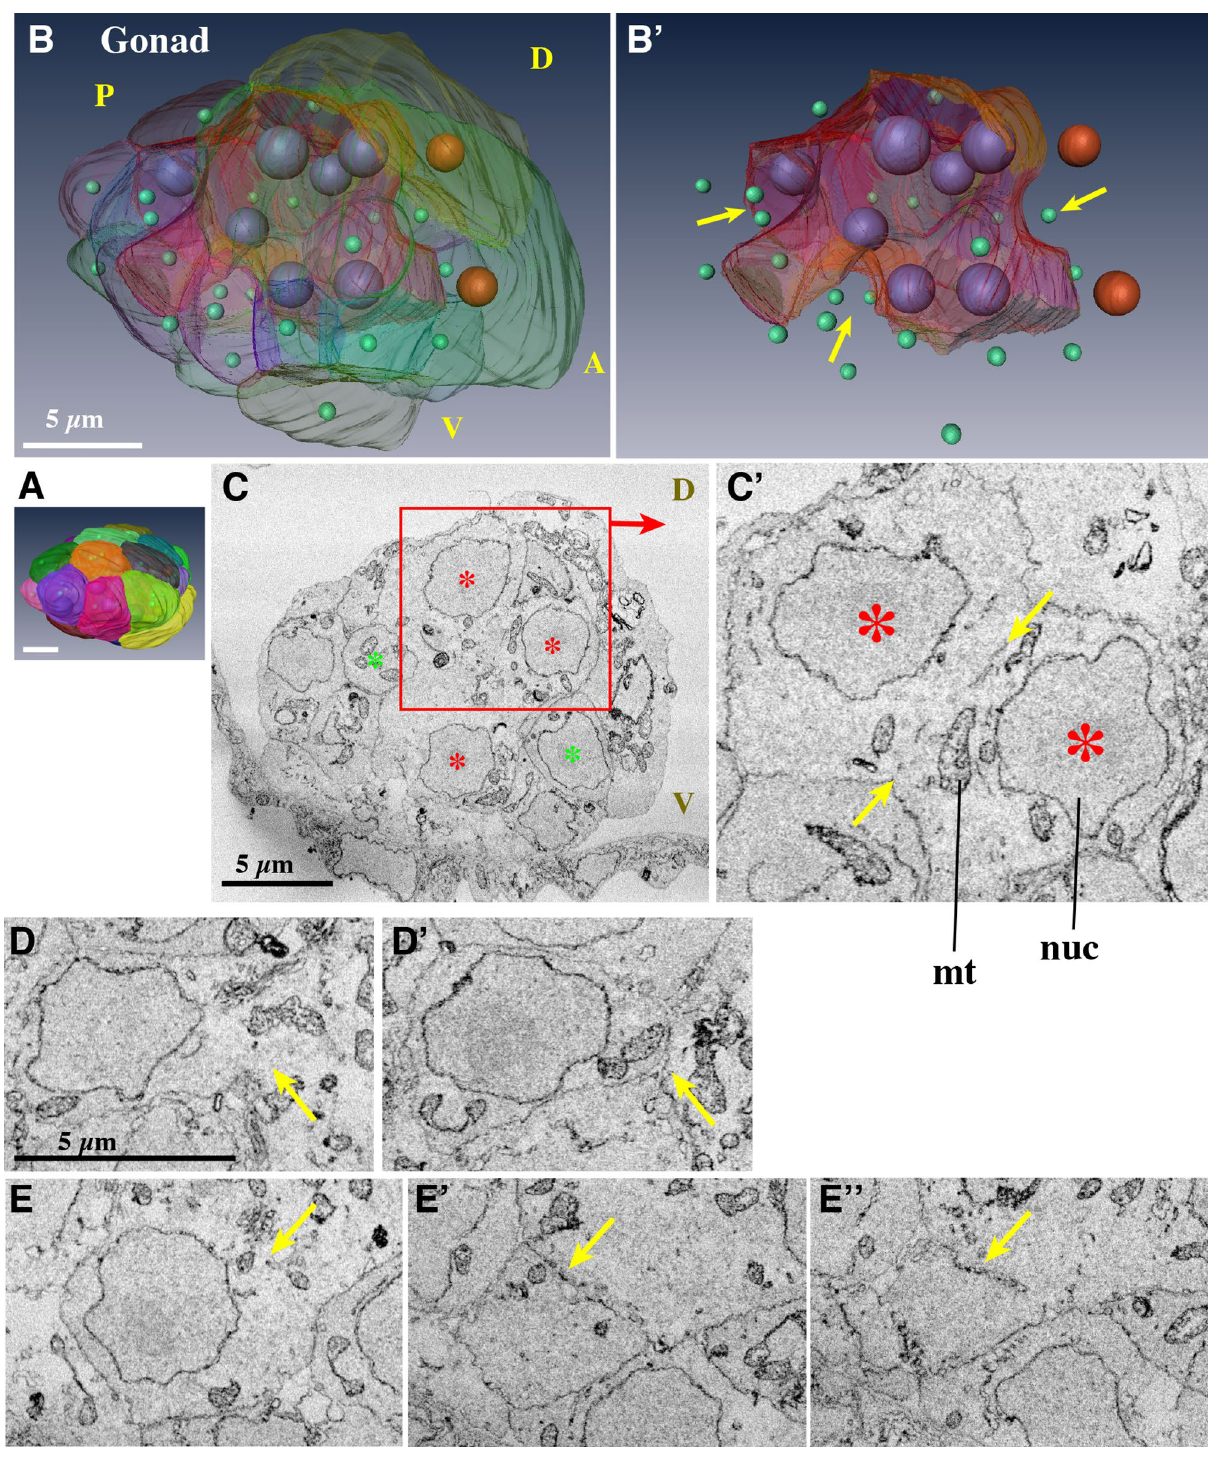
Figure 5. Gonad. ( A ) Surface view. Anterior is to the right. ( B ) Each cell is represented in a distinct transparent color. Seven large purple nuclei are shown within the central syncytium (red cell). Two large brown nuclei denote large surface cells (green and yellow cells). Other cells that have a single nucleus are indicated by small green nuclei. Note that the size and shape of the nuclei do not refect those in the sample and are presented as arbitrarily-sized spheres. See Supplementary Movie 19 and 20. ( B’ ) The central syncytium is shown in red. The arrows indicate grooves. ( C ) Section of the central syncytium. Three nuclei (asterisks) share cytoplasm. ( C’ ) Another section in the z-stack of the two nuclei that are shown in the rectangle in C . Putative cell membrane remnants are visible between the two arrows. ( D , D’ ) A cell that is fusing. The cell is fused to the central syncytium in D , but in another section, there is clear cell membrane between it and the adjacent cell in D’ (arrows). ( E , E’ , E’’ ) Another example of a fusing cell. Three sections of the cell. The cell is fused to the central syncytium in E . The cell membrane is fragmented in ( E’ ) (arrow). The membrane is continuous, but lost on the right side in ( E’’ ). ( A , B’ ) The images were generated using the Amira software package (ver. 5 and 6). Scale bars, 5